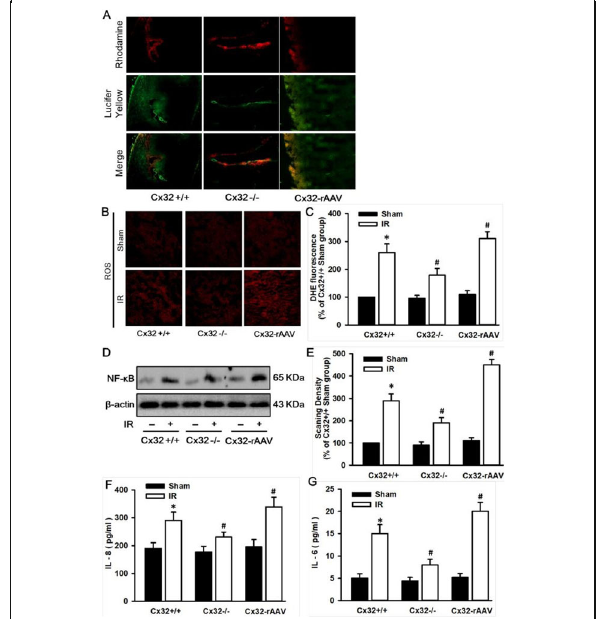
Fig. 2 (abstract 000565). Cx32 GJ regulates ROS/ NF- κ B axis- mediated senescent bystander effect following renal IR